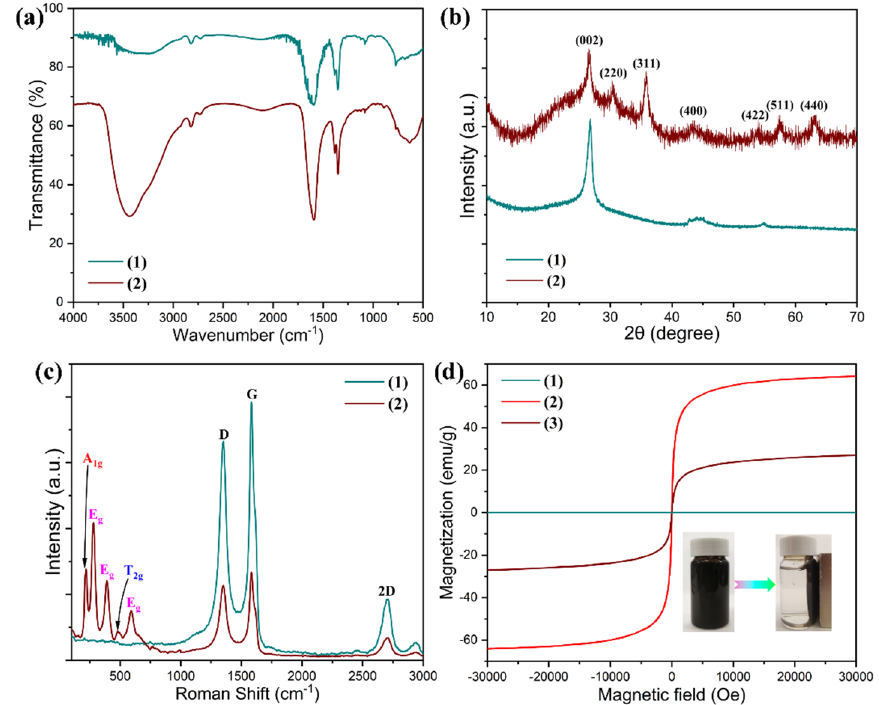
Figure 3. ( a ) FTIR spectra, ( b ) XRD patterns, and ( c ) Raman spectra of (1) pristine